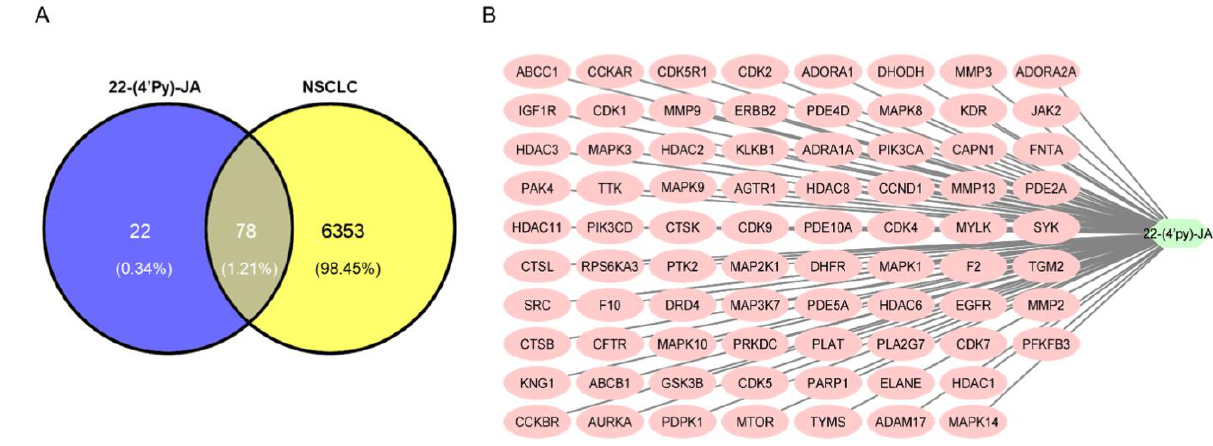
Figure 4. Compound target-disease target identification. ( A ) Venn diagrams represent the target interception between compound and disease. The blue part represents the number of 22-(4 ′ py)-JA targets, and the yellow part represents the number of non-small-cell lung cancer (NSCLC) targets. ( B ) A compound-target network was constructed by Cytoscape 3.9.1.